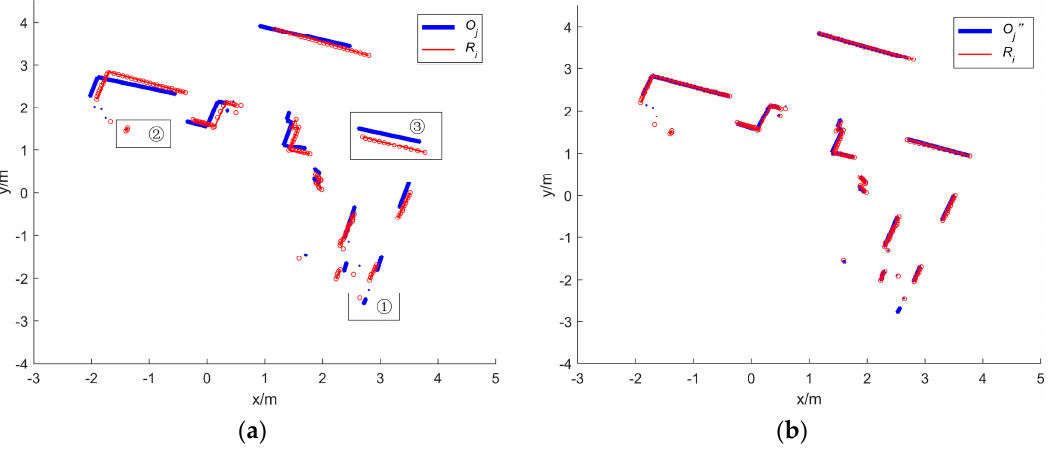
Figure 14. Simulation results of open-source datasets in Intel Research Laboratory: ( a ) point cloud line segment characteristics of two laser frames; ( b ) point cloud line segment features after data registration.